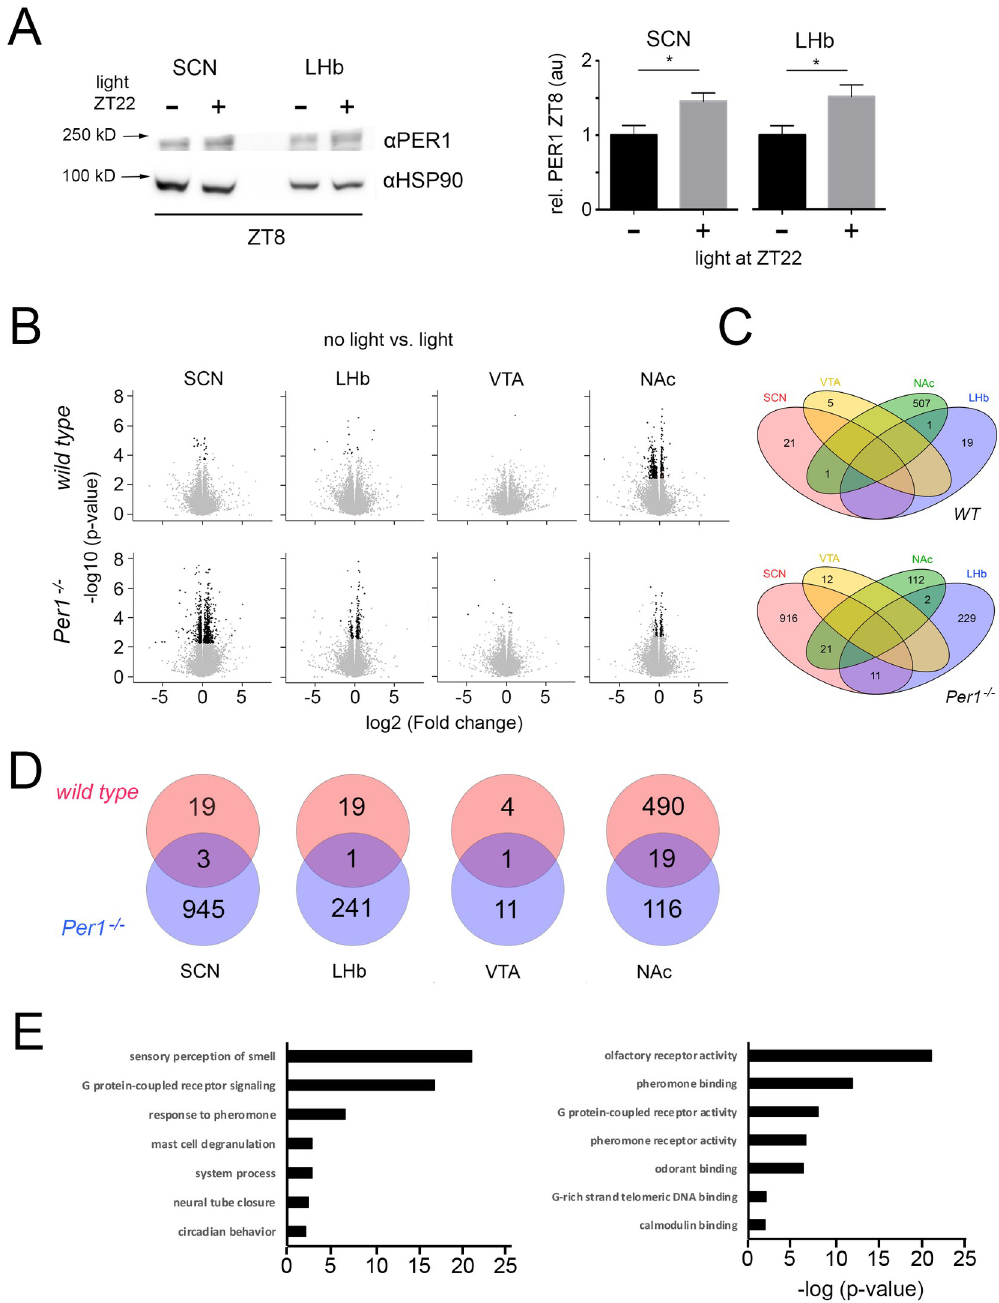
Fig 4. Light induction of PER1 protein at ZT8 and effects on the transcriptome in the brain. (A) Expression of PER1 protein at ZT8 in the SCN and the LHb after a light pulse at ZT22 compared to no light pulse. The left panel depicts an example of a Western blot and the right panel shows the quantification of three independent experiments. Unpaired t-test, n = 3, � p < 0.05, values are means ± SEM. (B) Volcano plots depicting the changes of gene expression in response to a light pulse at ZT22 in the indicated tissues of wild type and Per1 -/- mice. The RNA sequencing was perfomed 10 hours after the light pulse (ZT8). Black dots indicate significant changes, n = 6. (C) Venn-diagrams illustrating the overlap of gene expression changes in the four nuclei. Top comparison in wild type animals, bottom comparison in Per1 -/- mice. Numbers indicate the amount of genes affected by the light pulse. For the gene names see S1 Table. (D) Venn-diagram comparing wild type and Per1 -/- mice in a single nucleus. Numbers indicate number of genes affected by the light pulse. Genes are listed in S1–S9 Tables; SCN: wt (S2 Table), Per1 -/- (S3 Table); LHb: wt (S4 Table), Per1 -/- (S5 Table); VTA: wt (S6 Table), Per1 -/- (S7 Table); NAc: wt (S8 Table), Per1 -/- (S9 Table). (E) TopGO analysis of biological processes (left) and molecular functions (right) in the NAc of wild type animals.